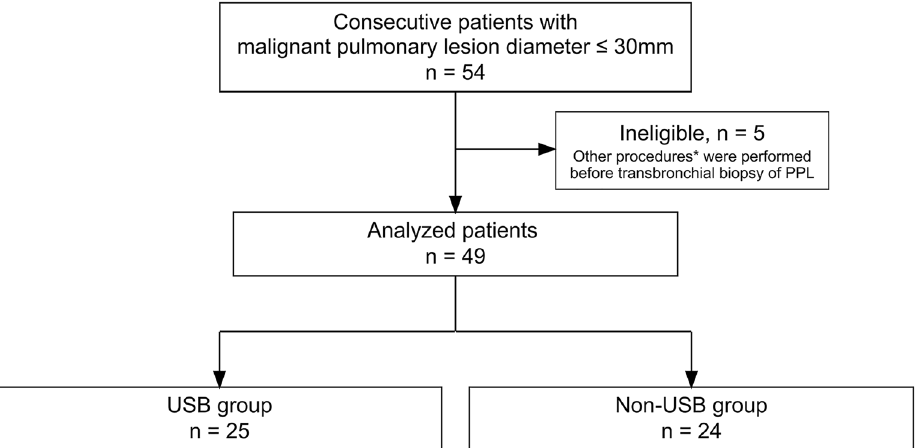
Figure 1. Flow diagram. Forty-nine patients who underwent bronchoscopy and had a malignant pulmonary peripheral lesion (PPL) with a diameter of ≤ 30 mm were retrospectively analyzed for diagnostic yield. *Other procedures consisted of endobronchial ultrasound–guided transbronchial needle aspiration and collection of bronchial alveolar lavage